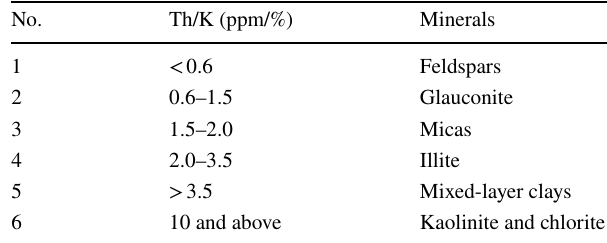
Table 2 Clay minerals classification based on Th/K (ppm/%)